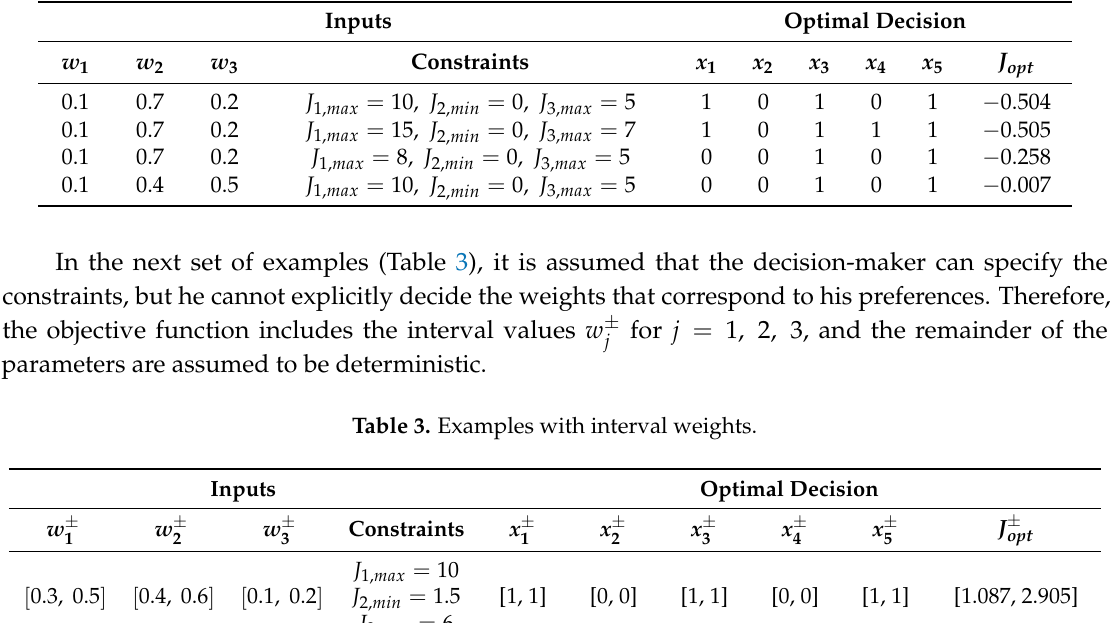
Table 2. Examples without uncertainty.